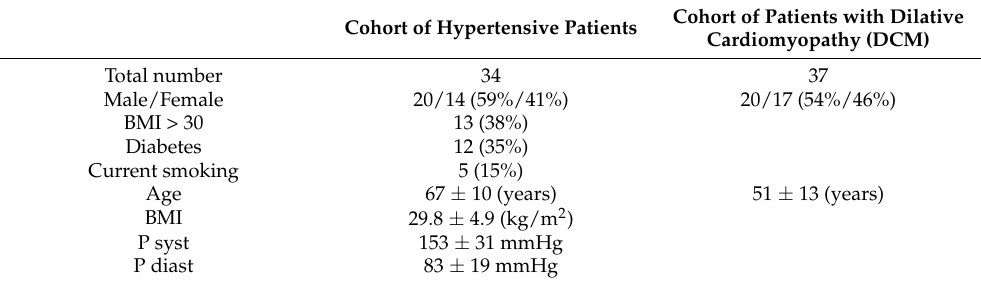
Table 1. Patients’